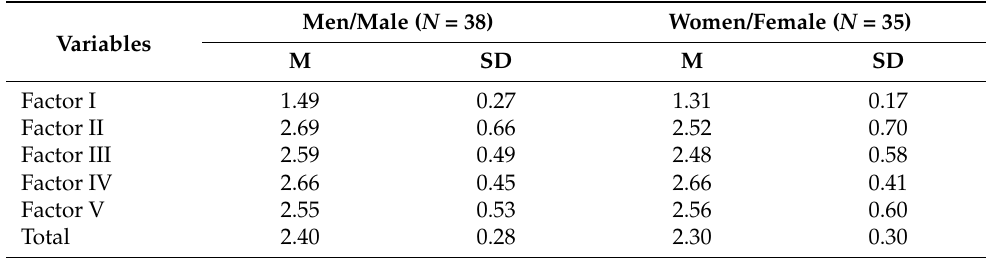
Table 4. Mean and standard deviation of perceptions of attention to diversity based on sex and gender. Variables